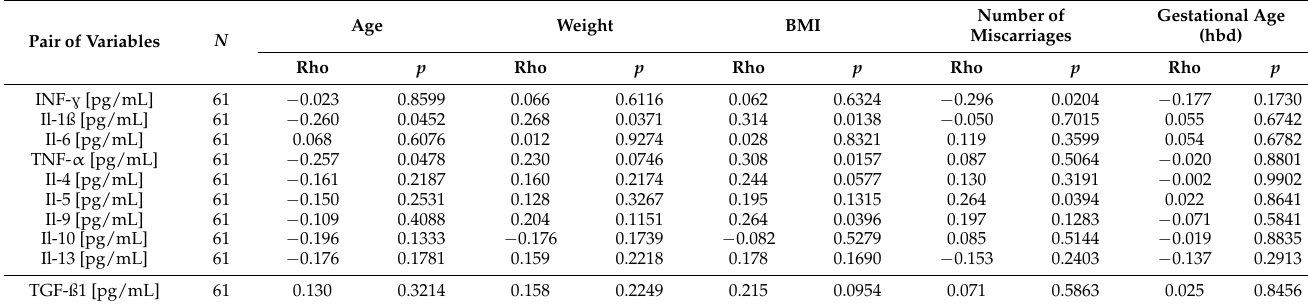
Figure 3. A scatter graph showing the correlation between the number of miscarriages and the concentration of IL-5 assessed in the blood serum of patients from the study group. Table 3. Spearman rank correlation between selected demographic variables and serum cytokines evaluated in the study group.